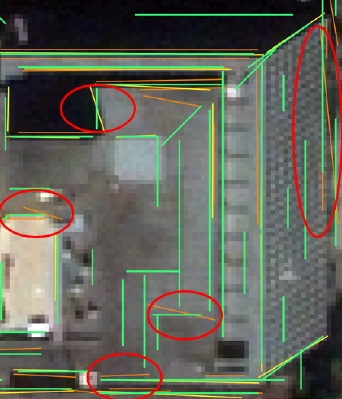
Figure 6. Edge detection around a tennis court with varying edge strength. Top left are edges detected using LSD, top right are edges from EDLines. Bottom Left are edges obtained from Hough lines and bottom right is the edge detection framework.